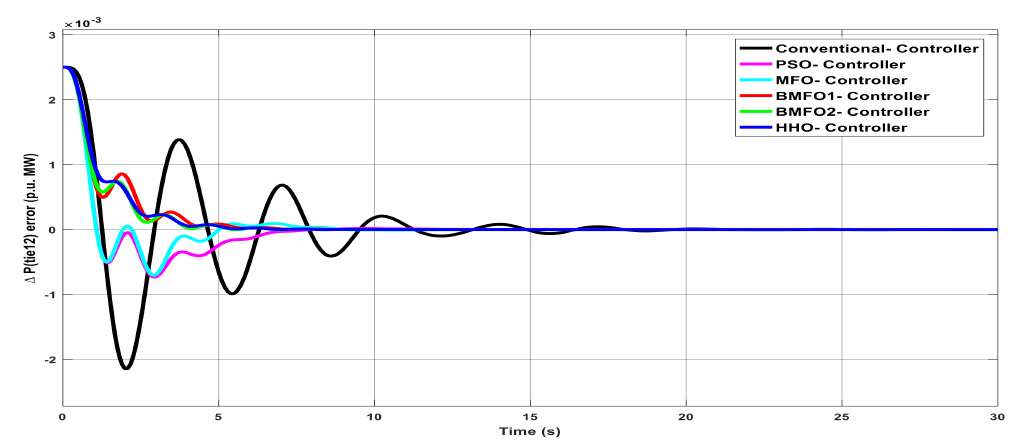
Figure 18. Deviation in tie-line error with various controllers under contract violation